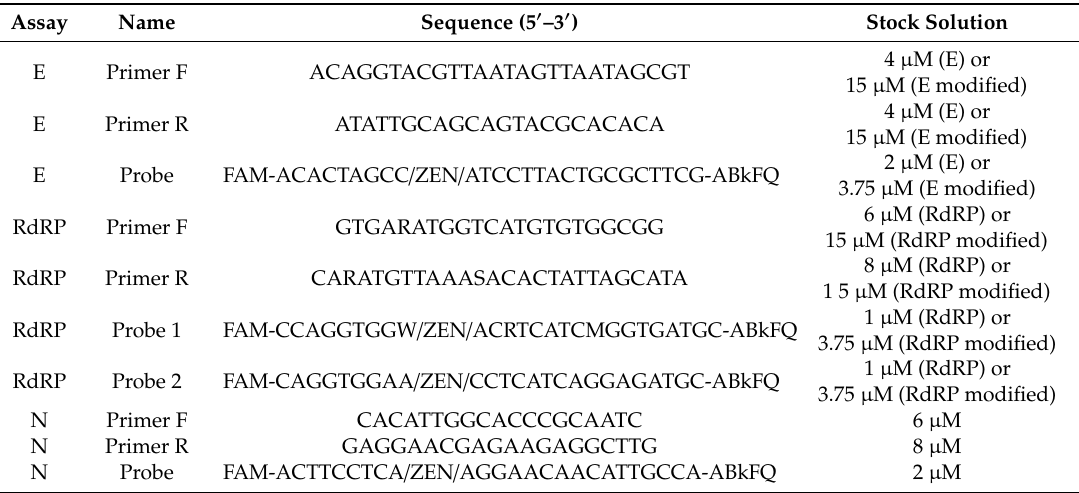
Table 1. RT-PCR primer and hydrolysis probe sequences, according to Corman et al., 2020 [4]. Assay